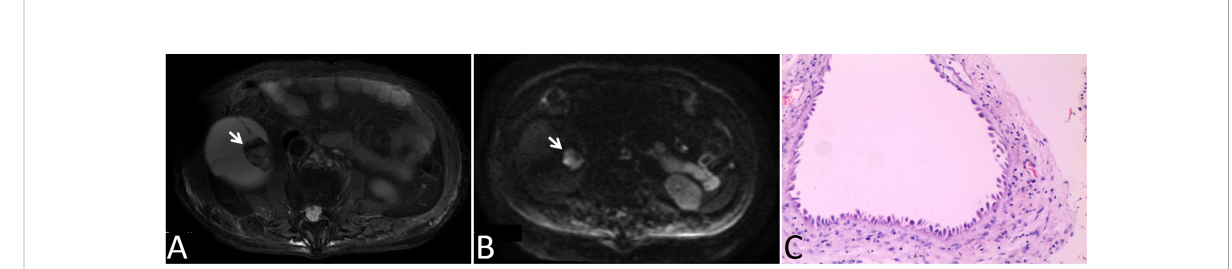
FIGURE 4 Images in a 78-year-old man with a cystic mass in the right kidney. (A) Axial T2-weighted MR image shown mural nodular soft tissue (arrow), (B) Axial DWI (b = 1000 s/mm2) image shown remarkably high signal intensity of the wall nodule (arrow), (C) This lesion was surgically removed and determined to be a multilocular cystic renal neoplasm of low malignant potential.